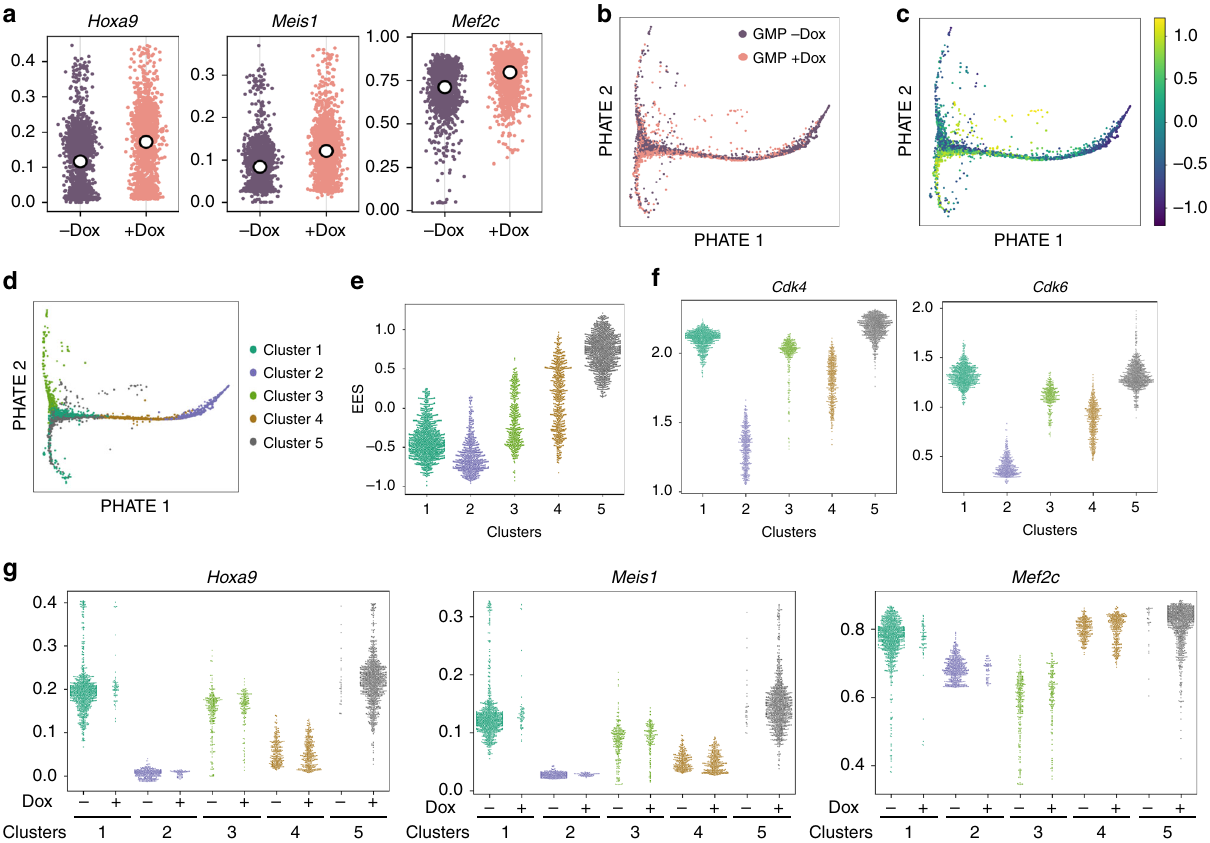
Fig. 4 MLL-AF9 preserves the heterogeneous gene expression states as analyzed by scRNA-seq. a Swarm plots showing the expression levels of Hoxa9 , Meis1 , and Mef2c in cultured GMPs in the presence or absence of Dox. White dots indicate mean of each sample. b PHATE plot of cultured GMPs in the presence (pink dots) or absence of Dox (purple dots). c Pseudocolor denoting enhanced experimental signal (EES) is overplayed on the PHATE plot. EES is derived by comparing the GMPs cultured in the presence or absence of Dox, where a larger EES score indicates more enrichment in the + Dox GMPs. d Based on their gene expression similarity, fi ve clusters of cells were determined. Their positions on the PHATE plot are shown. e EES of individual cells within each cluster. f Expression levels of Cdk4 and Cdk6 in each GMP cluster. g Expression levels of Hoxa9 , Meis1 , and Mef2c in each GMP cluster. The values for cells cultured in the absence or presence of Dox were plotted